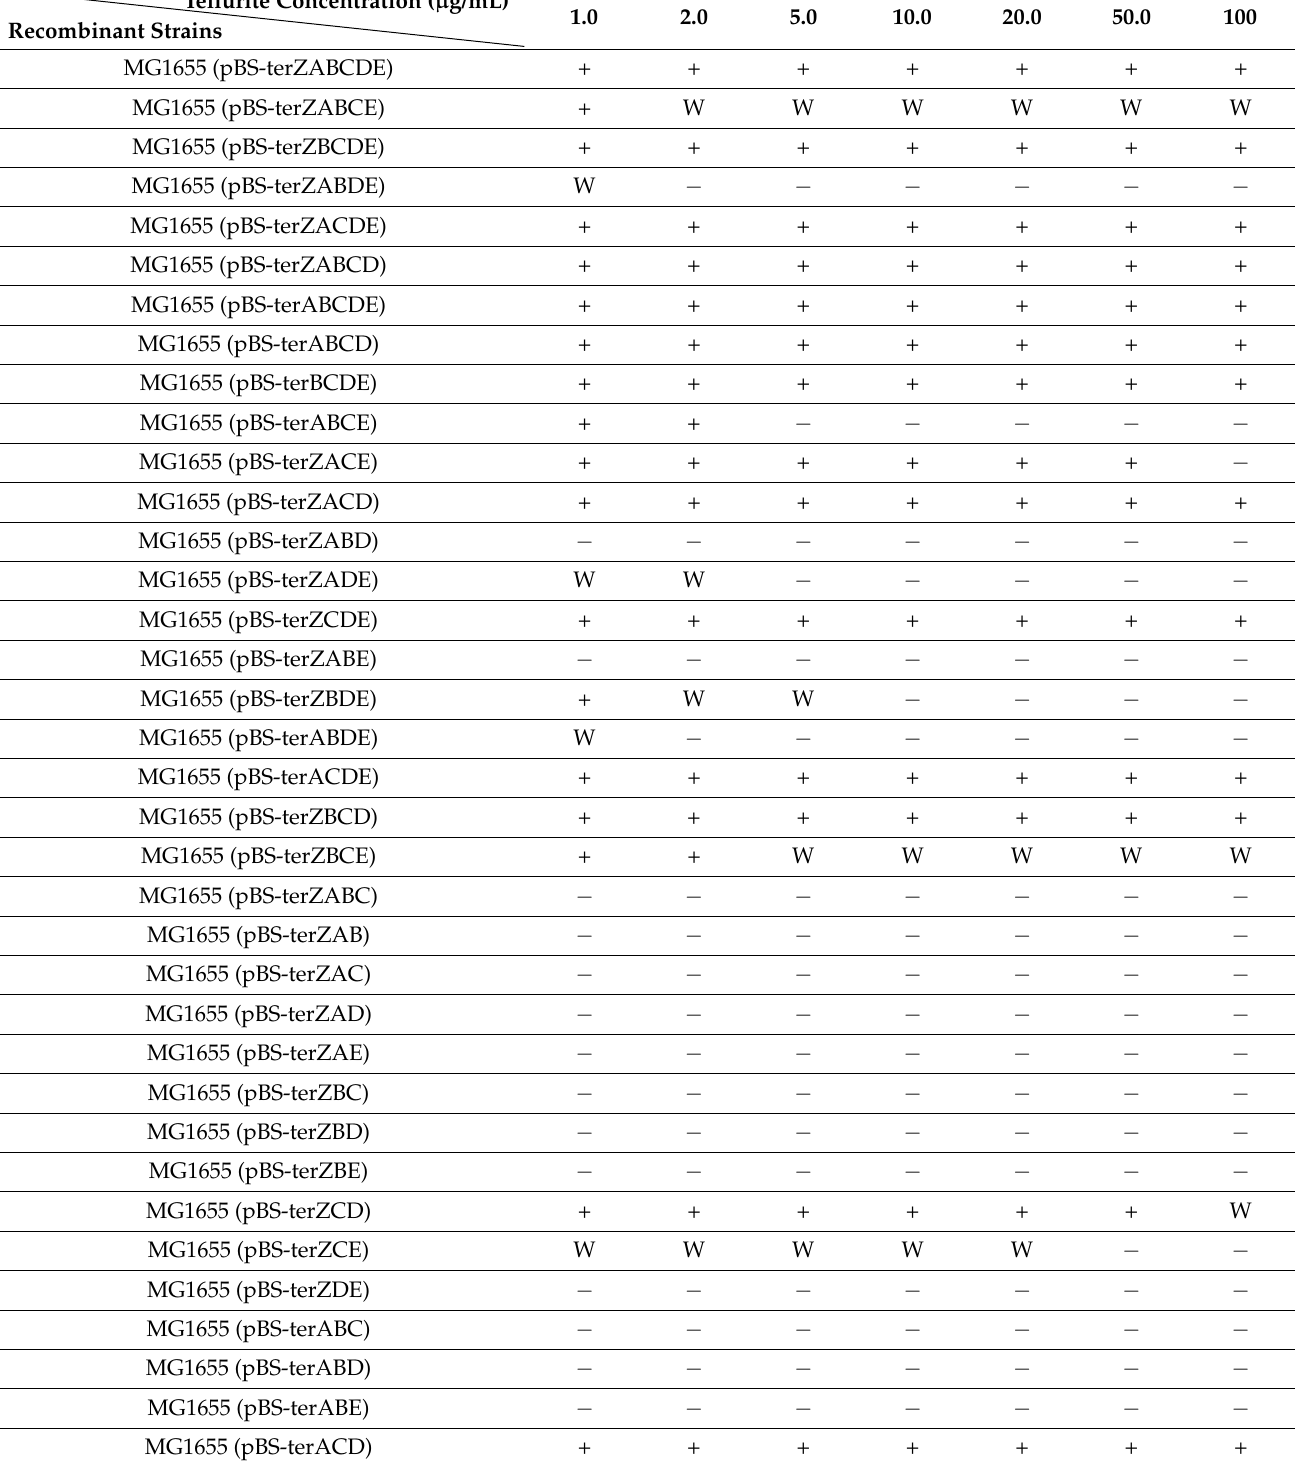
Table 2. Tellurite resistance of the recombinant E. coli MG1655 containing different gene combinations of terZABCDE gene cluster in P. citronellolis